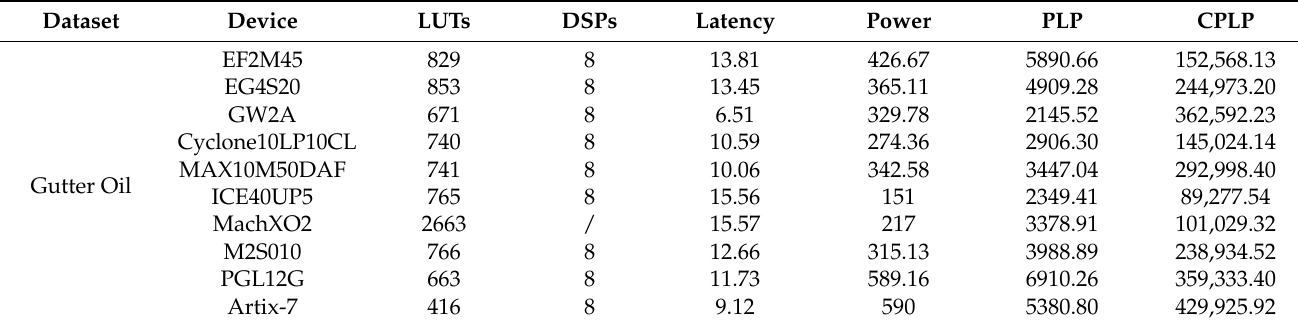
Table A7. SVM deployment results on the low-cost